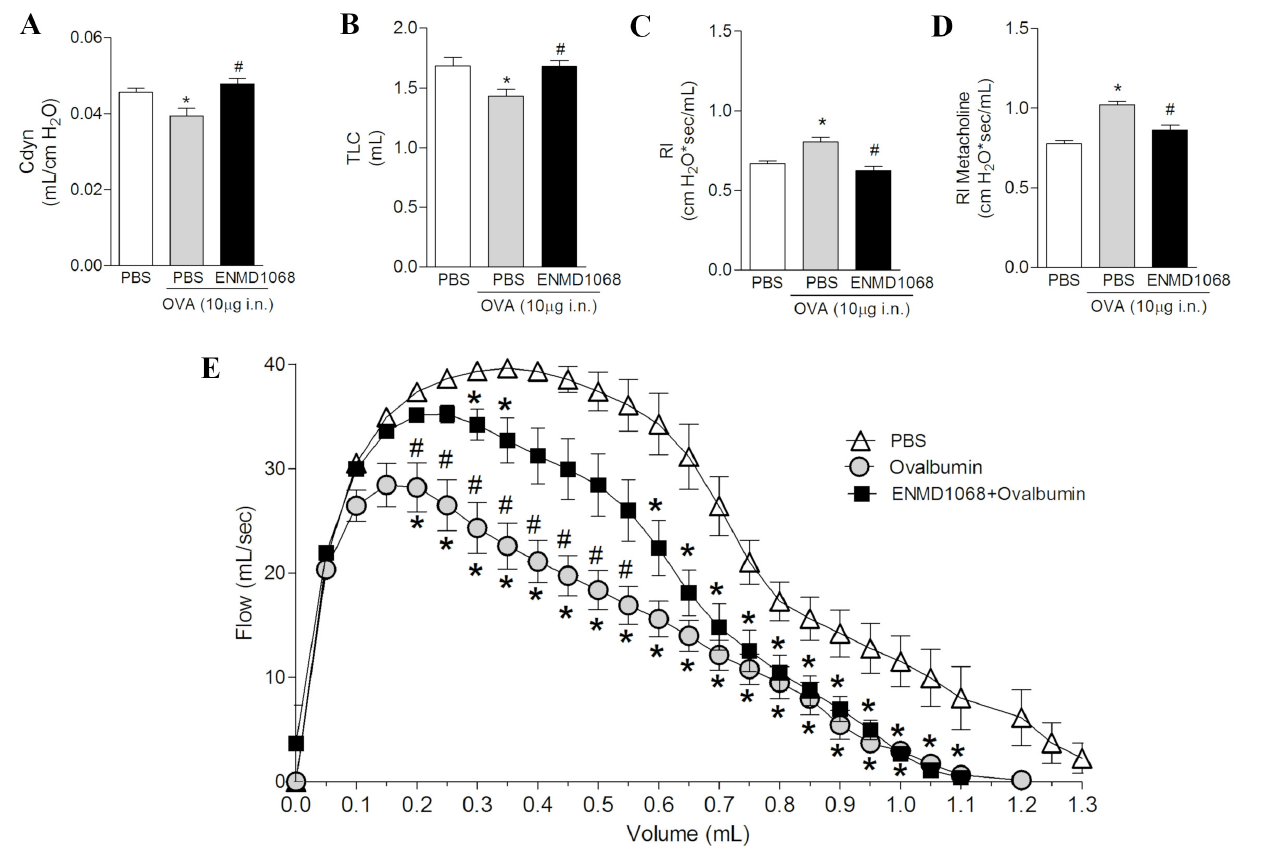
FIGURE 3 - PAR2 blockade modulates pulmonary function in mice. Effects of PAR2 antagonist ENMD1068 (0.5 mg/kg) treatment on the parameters of respiratory mechanics 48 hours after the last intranasal allergen challenge. (A) Cdyn: dynamic compliance; (B) TLC: Total lung capacity; (C) RI: lung resistance; (D) RI methacholine: Bronchoprovocation’s test using methacholine (1 mg/kg); (E) flow-volume curve. The results are representative of 2 independent experiments and are expressed as the mean ± SEM of 6-8 mice/group. *p<0.05 compared to the PBS group and # p<0.05 ENMD1068 group when compared